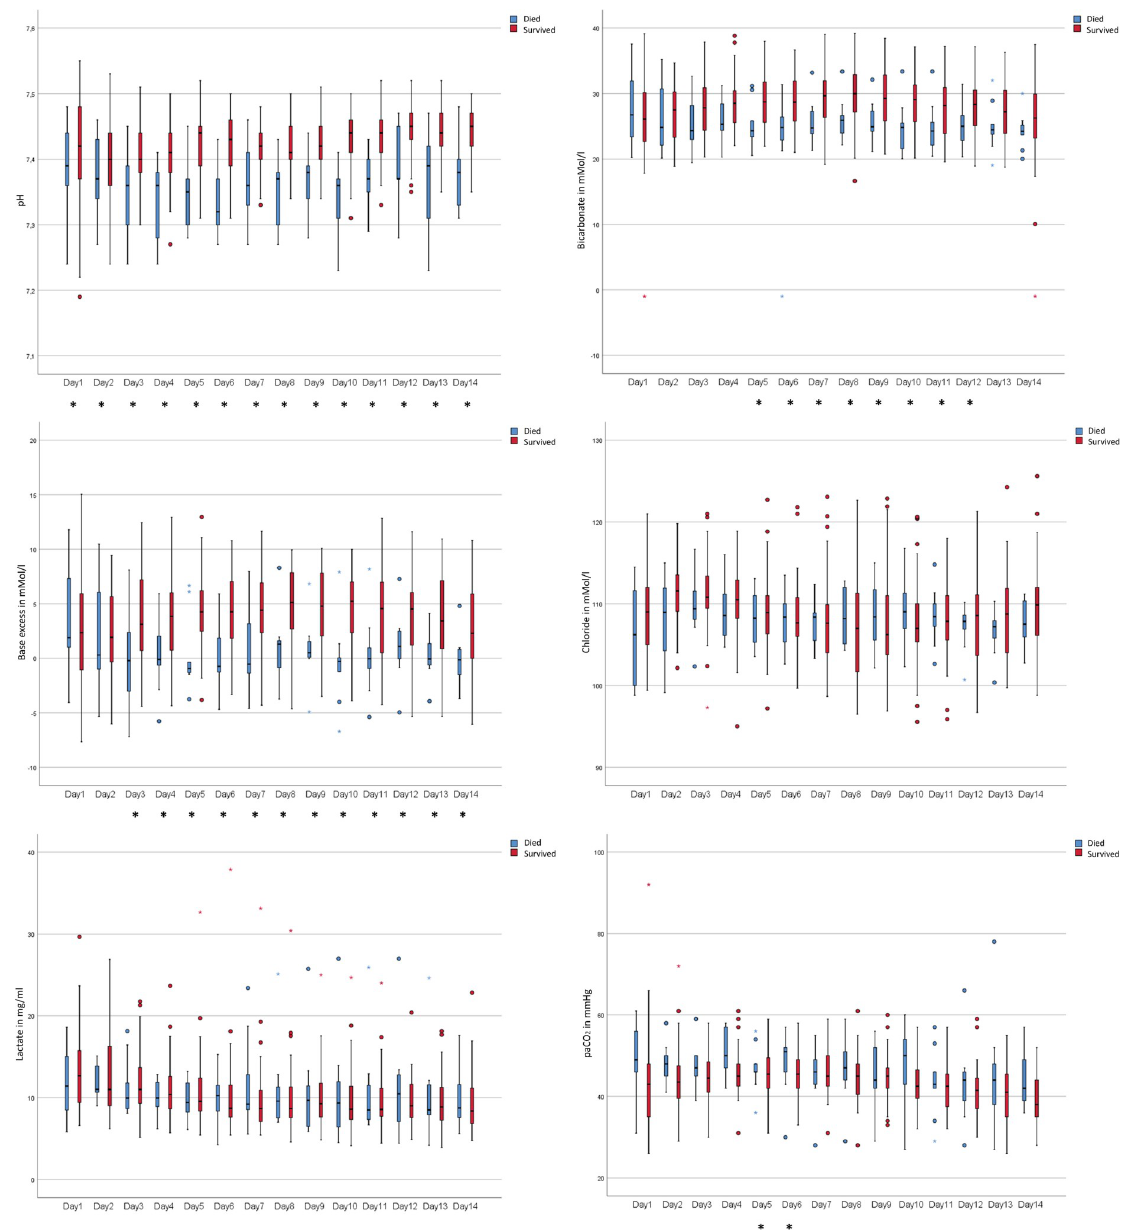
Fig 3. Daily mean values of blood pH, bicarbonate, base excess, chloride, lactate, and arterial partial pressure of carbon dioxide (paCO 2 ) during the 14-day observation period for survivors and non-survivors: Values for pH, bicarbonate, and base excess were lower in non-survivors. Significant differences between the two groups are marked with an asterisk in the legend of the x-axis.